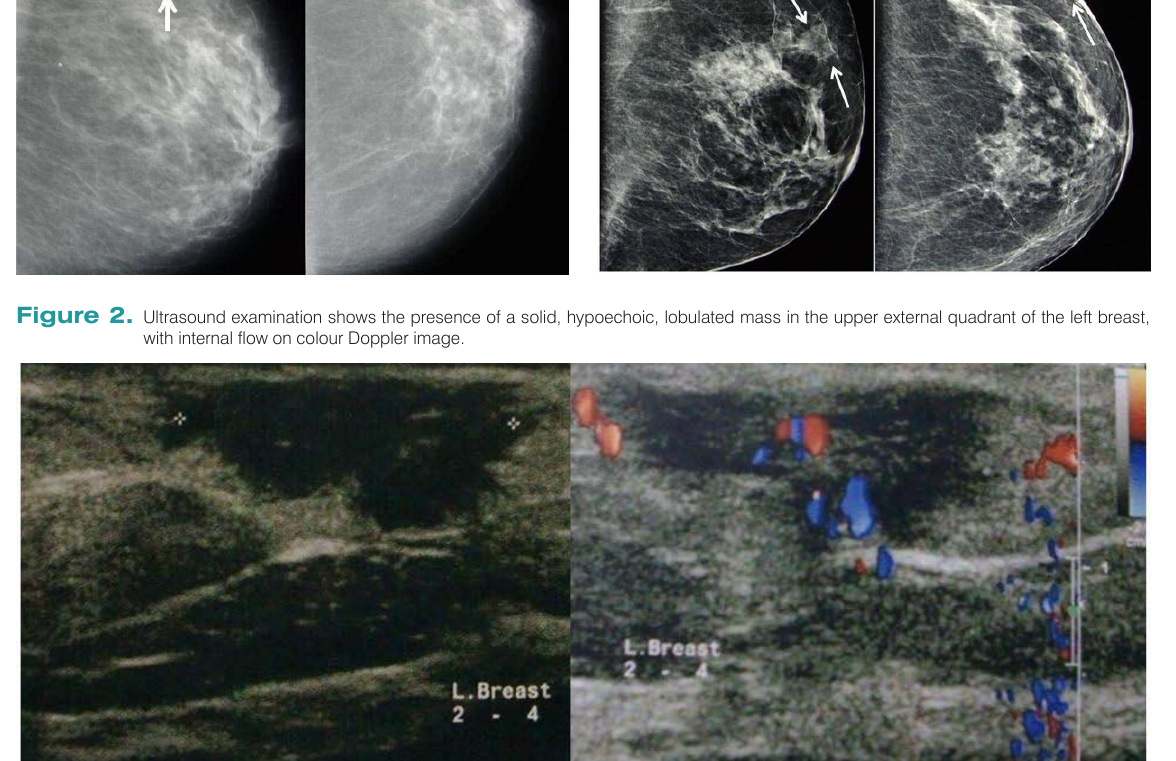
Figure 1a. Mediolateral oblique and cranio-caudal views on the last previous mammogram revealed a slightly increased density in the upper outer quadrant of the left breast (arrows), with no skin thickening or axillary lymph nodes present .The mass was missed in diagnosis.